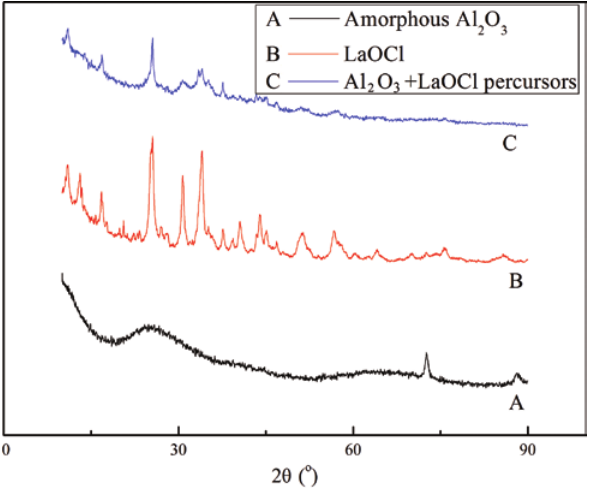
O , micro crys- 2 3